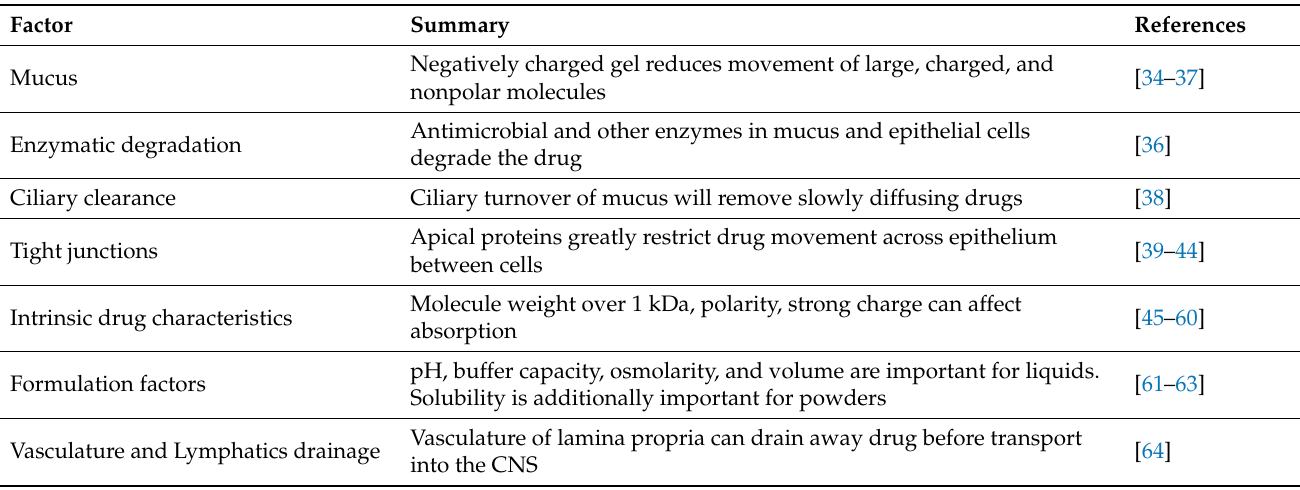
Table 1. Description of factors affecting intranasal